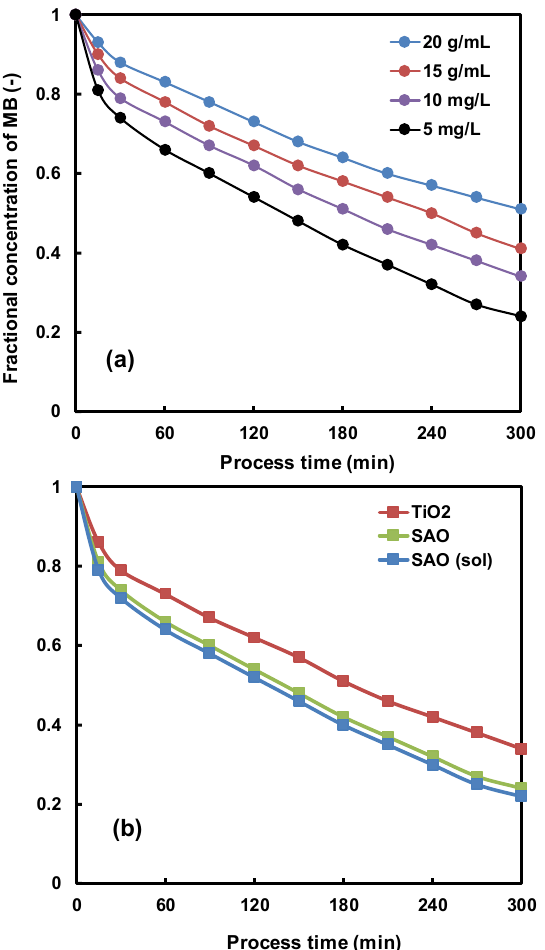
Figure 9. Variation of the concentration of MB by the photocatalytic decomposition on titanium dioxide (TiO 2 ) with ( a ) various initial concentrations and ( b ) on SAOs at an initial MB concentration of 10 mg/L.